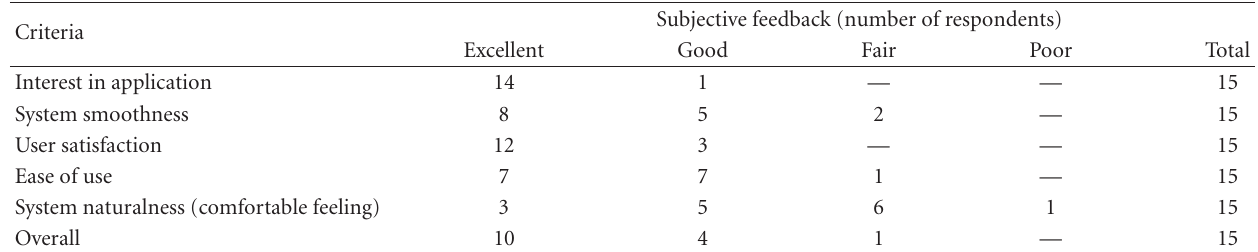
Table 1: Qualitative feedback from